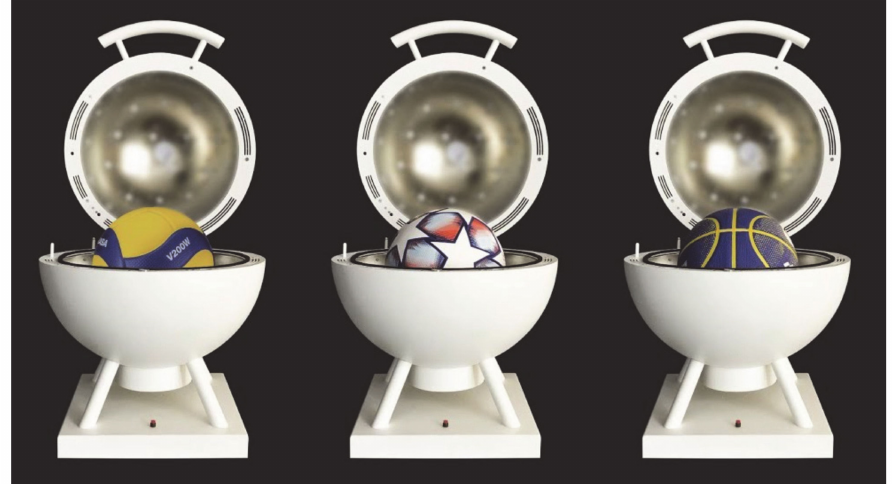
Figure 11. Picture of the manufactured prototype with the different tested balls.